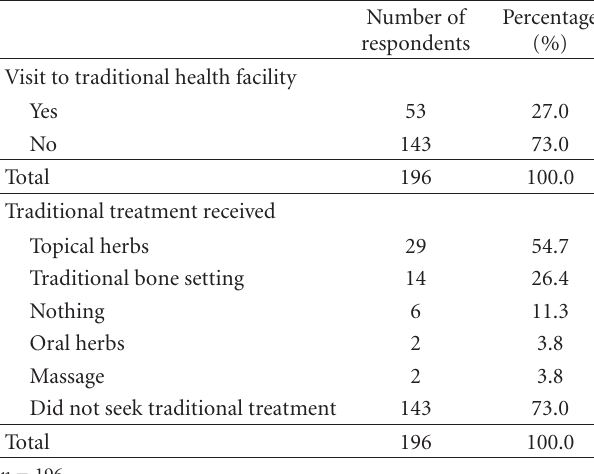
Table 4: Use of traditional health facility for functional problems by households.